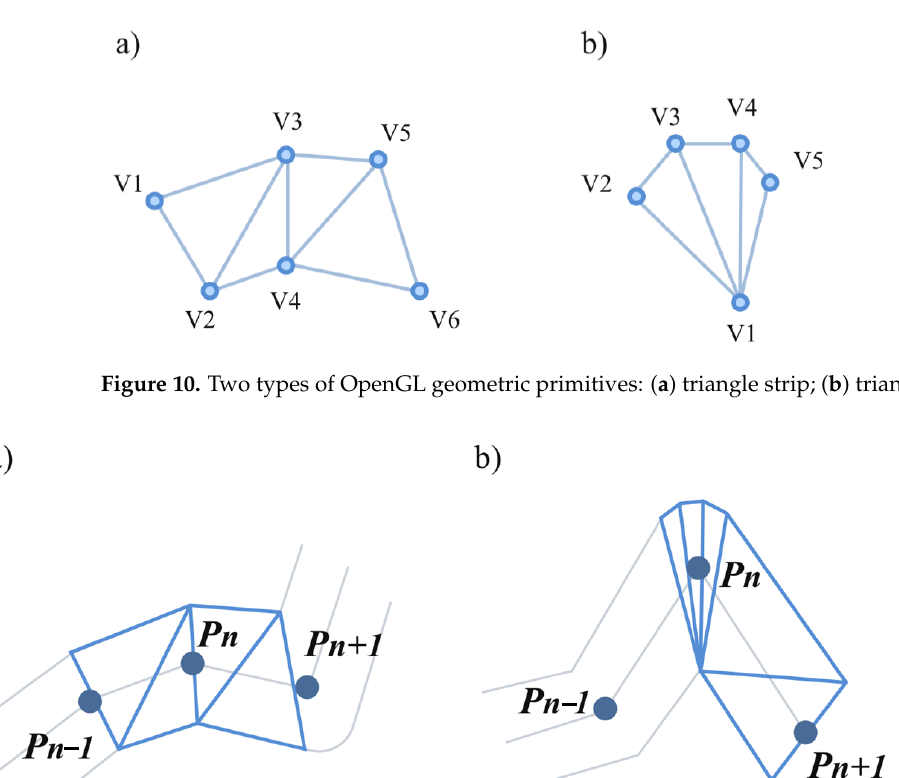
Figure 11. The application of two types of geometric primitives to GIS line symbol rendering: ( a ) wide line segment